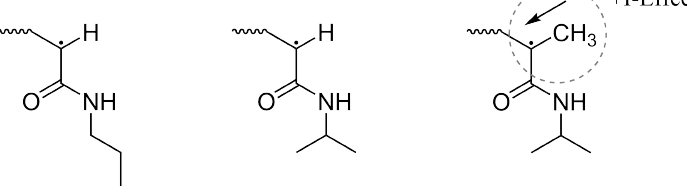
Figure 6. Structural formulas of the various acrylamide radicals during polymerisation (left to right: NNPAM, NIPAM and NIPMAM). In NIPMAM, the radical is stabilized by the methyl group and its positive inductive effect, whereby the polymerization rate is